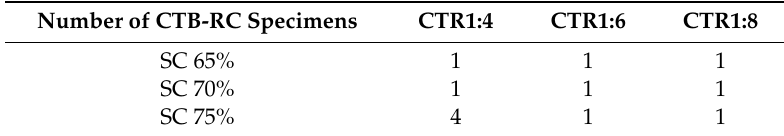
Table 4. Number of CTB-RC specimens of di ff erent CTR and SC